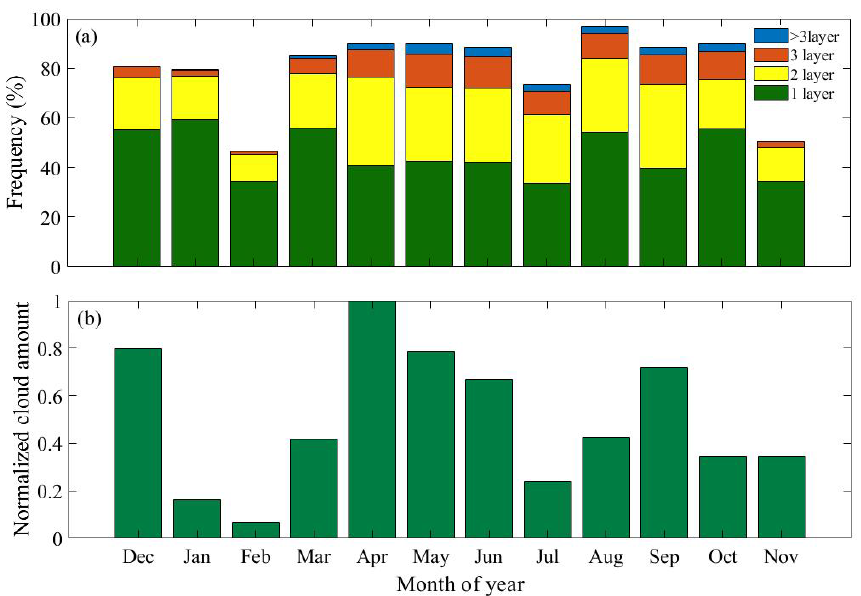
Figure 17. Monthly variation in cloud frequency distribution and cloud cover from December 2020 to November 2021: (a) monthly variation in the frequency of the number of cloud layers. (b) Monthly variation in cloud